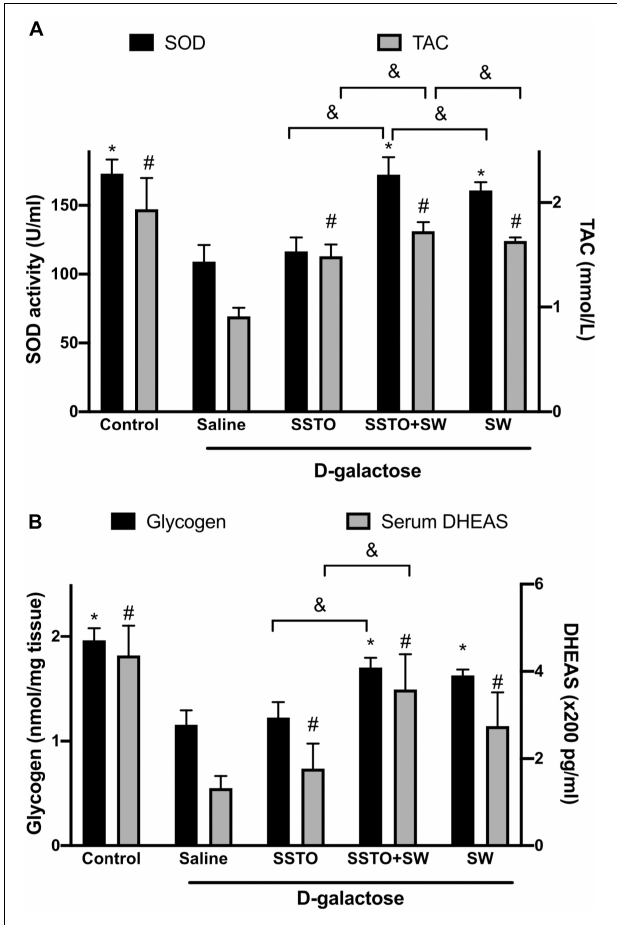
FIGURE 4 | Biochemical analysis of serum and muscle. (A) Effects of SSTO and/or swimming on serum SOD (black bars) and TAC (white bars) antioxidant enzyme activity. (B) Glycogen content (black bars; left y -axis) in the soleus muscle and serum DHEAS level (white bars; right y -axis). * # Statistically significant difference as compared with the aged rats with saline treatment; & statistically significant difference when compared with SSTO + swimming